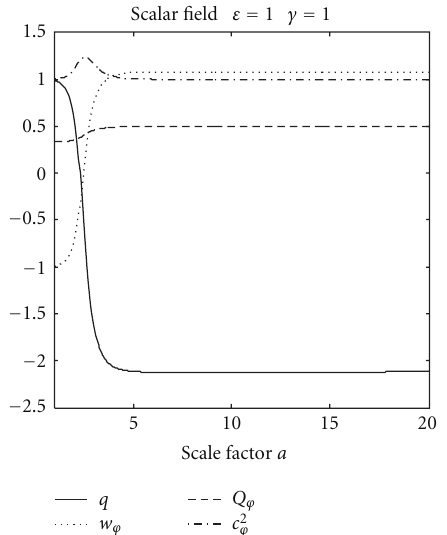
Figure 8: Evolution of q , w ϕ , Q ϕ , and c 2 observe the same transition from inflation to sti ff matter for the scalar field. Initial conditions are ˙ ϕ i = 100 and ϕ i = 1.